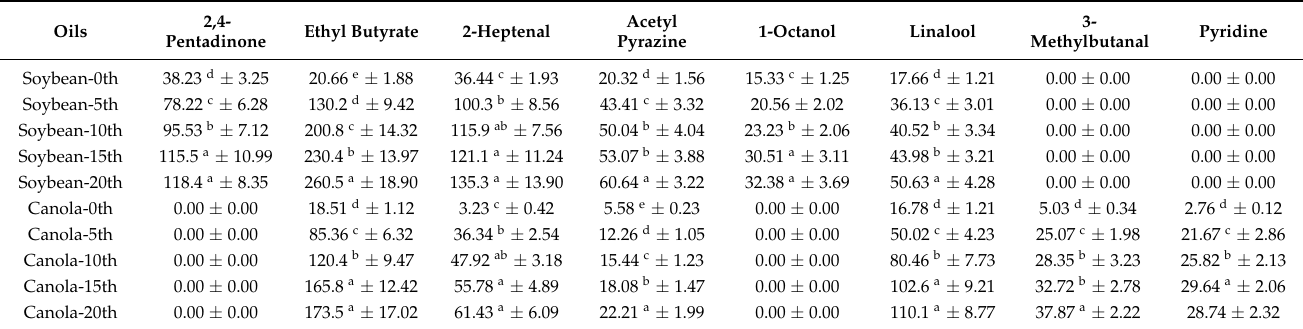
Table 2. Volatile compounds in repetitively fried soybean and canola oils using electronic nose